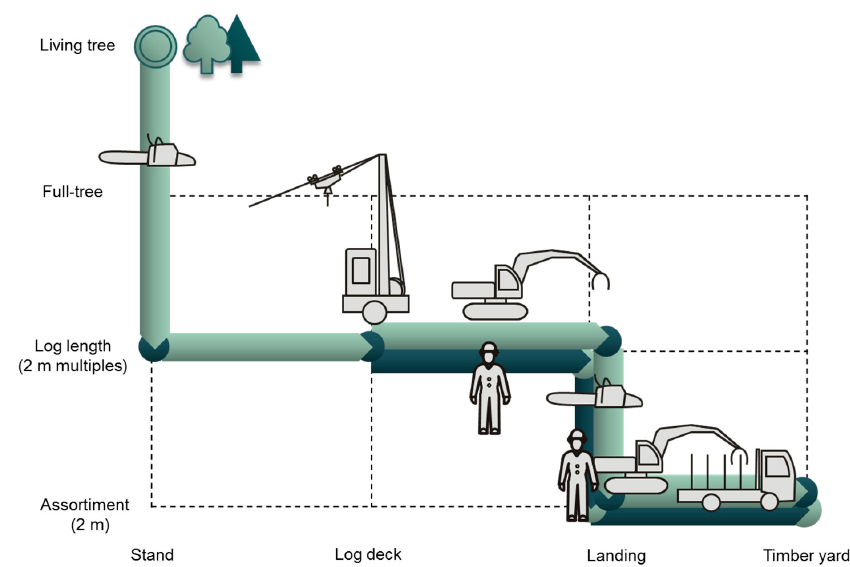
Figure 1. Matrix of the semi-mechanized harvesting system with a cable yarder (after [13]). The x -axis shows extraction/transportation pattern with increasing distance from the felling location. The y -axis indicates the varying tree processing stages (in inverted order). The light green colored production chain represents the preferred and studied set-up including mechanized log manipulation subsequent to the yarding process, whereas the dark green colored production chain represents the manual approach.